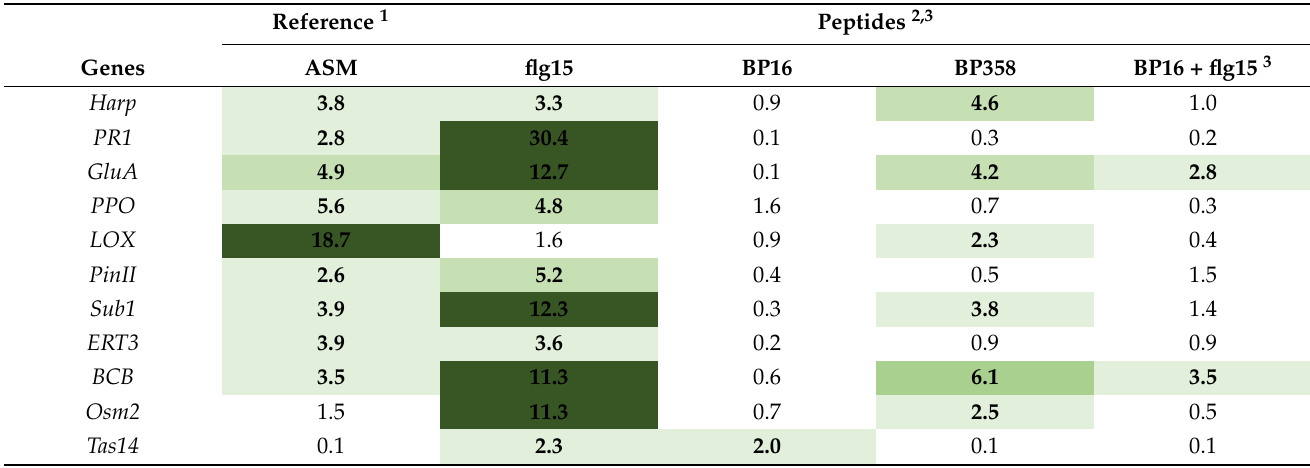
Table 3. Expression of genes related to defense response in tomato after the treatment with the reference compound acibenzolar- S -methyl (ASM), peptides flg15 , BP16 , and BP358 , and a mixture of BP16 and flg15 ( BP16 + flg15 ). Fold induction above 2 was considered overexpression in the relative quantification using the ΔΔCt method. Significant values are indicated in bold.